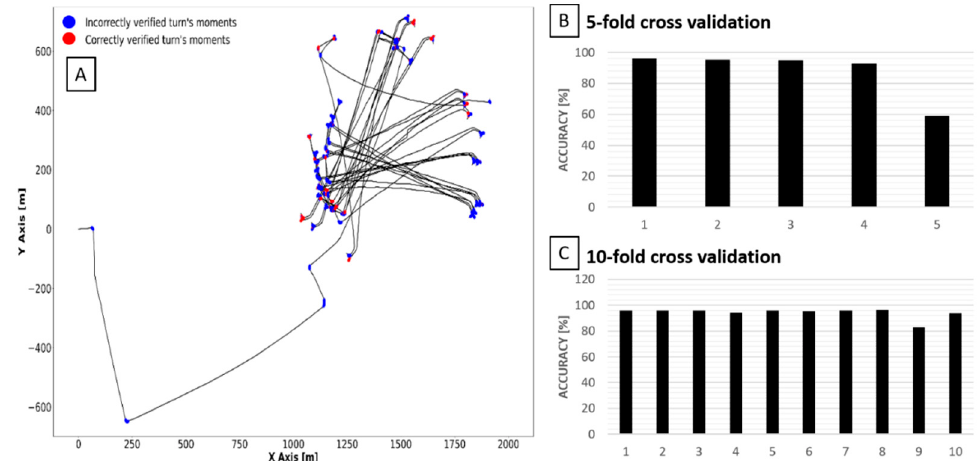
Figure 7. Result of the final model: ( A ) Visual representation of results; ( B ) 5-fold cross-validation; ( C ) 10-fold cross-validation. Table 3. Performance of the selected random forest model on two additional testing